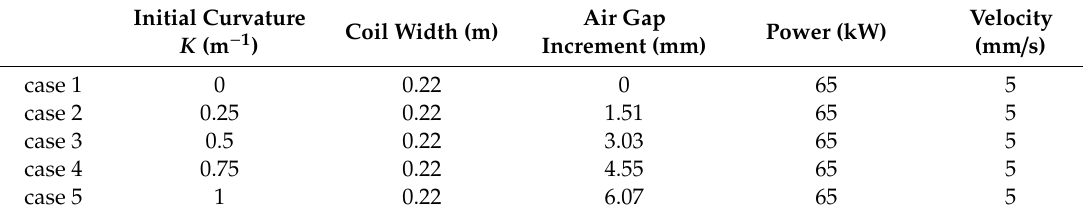
Figure 10. Heat generation in section S 1 –S 1 . We performed the five heat source models on the heat transfer and mechanical analysis, and the plastic strain distribution and displacement were calculated. Figure 11 shows the plastic strain on the bottom surface (without the inductor side) of the plate along the section S B – S B , which is vertical to the heating line, and the thickness is 20 mm. The strain was divided into in-plane strain and out-of-plane strain according to Equations (12) and (13). The strain components in the X and Y directions are shown. With the curvature of the plate increasing, the out-of-plane strain in the heating area becomes less homogeneous—lower in the center and higher on the side. This occurs because the air gap